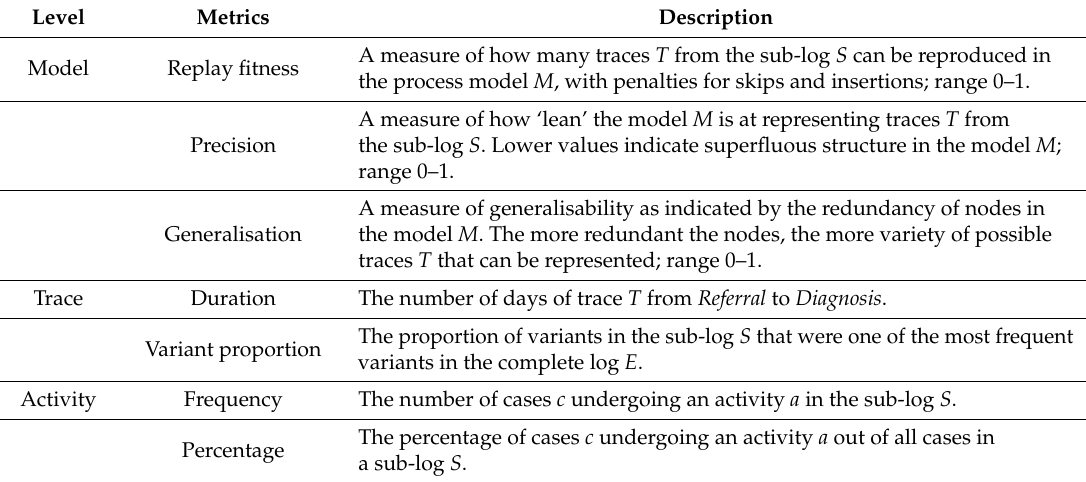
Table 2. Metrics for multi-level process analysis.